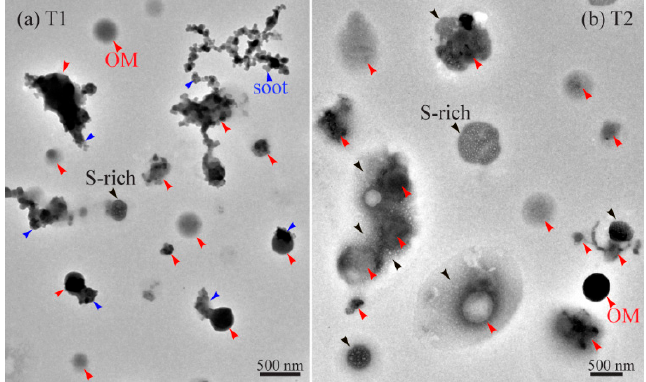
Figure 7. TEM images of aerosol particles at the T1 site ( a ) and the T2 site ( b ). The arrows in red, black, and blue indicate OM, S-rich, and soot particles, respectively.